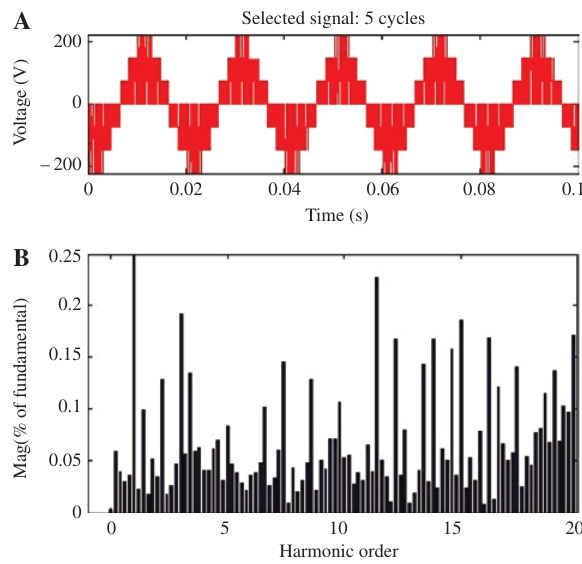
Selected signal: 5 cycles A